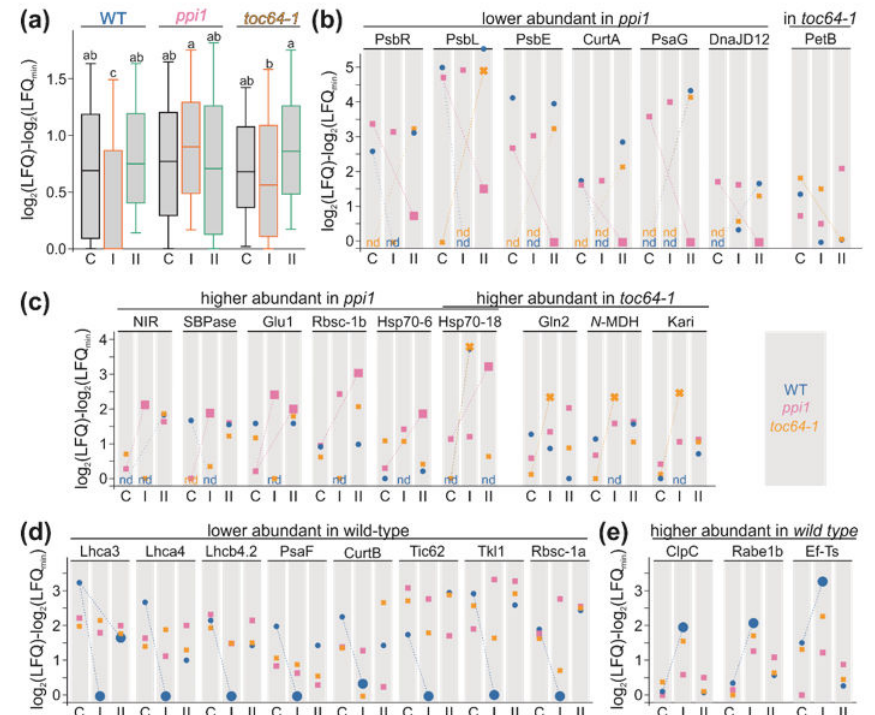
Figure 5. Abundance of plastidic proteins in chloroplast fractions after heat stress. ( a ) The distribution of the log 2 (LFQ) values for a protein normalized by subtracting the smallest found value was analyzed for each probe. The box plot presentation is shown. The di ff erence in the distribution was analyzed by ANOVA. ( b – e ) The log 2 (LFQ)-log 2 (LFQ min ) values are plotted for proteins with a di ff erence > 1.65 between control, and one HS-treated sample for at least one genotype. The symbols are colored according to the legend. Enlarged symbols and dashed lines indicate changes ( > 1.65) after HS. Dotted lines indicated changes ( > 1.65), assuming that the absence of detection suggests a protein abundance lower or equal to the lowest LFQ value observed for this